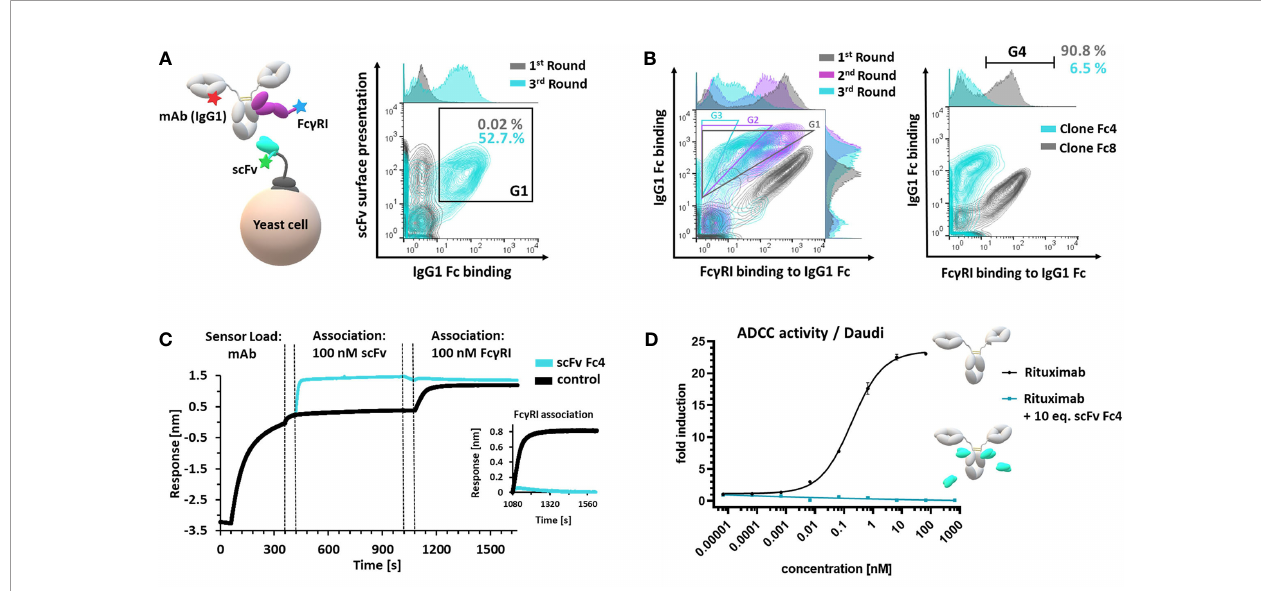
FIGURE 2 | Generation and characterization of a Fc g R-blocking anti-isotypic masking unit. (A) Schematic depiction of scFv yeast surface display via scFv-aga2p- aga1p system. scFv display (c-terminal c-myc tag), antibody (mAb(IgG1)) and simultaneous Fc g RI binding was veri fi ed using fl uorophore-conjugated proteins and fl uorophore-conjugated detection reagents (left panel). Enrichment of Fc-binding scFvs – comparison of the fi rst and third sorting round. Cells, displaying a functional c-myc tag and demonstrating Fc-binding (G1) were sorted in three consecutive FACS rounds (right panel). (B) Overlay of three consecutive FACS rounds, sorting for scFv-displaying cells binding to Fc and simultaneous blocking the Fc g RI interaction ( fi rst round: G1; second round: G2; third round: G3) (left panel). Single clone analysis of single clones Fc4 and Fc8. Cells located in G4 binding to Fc and simultaneous displaying Fc g RI binding. (C) BLI epitope binning. Monoclonal antibody (cetuximab, IgG1) was loaded onto Fab2G sensor tips. Control sample comprised no scFv during the fi rst association step. Dashed lines represent 60 seconds- quenching steps using kinetics buffer. (D) ADCC reporter-cell assay using CD20-positive Daudi cells. Rituximab (IgG1) alone or rituximab (IgG1) pre-incubated with 10 molar equivalents scFv Fc4 was used. Error bars represent standard deviation derived from experimental